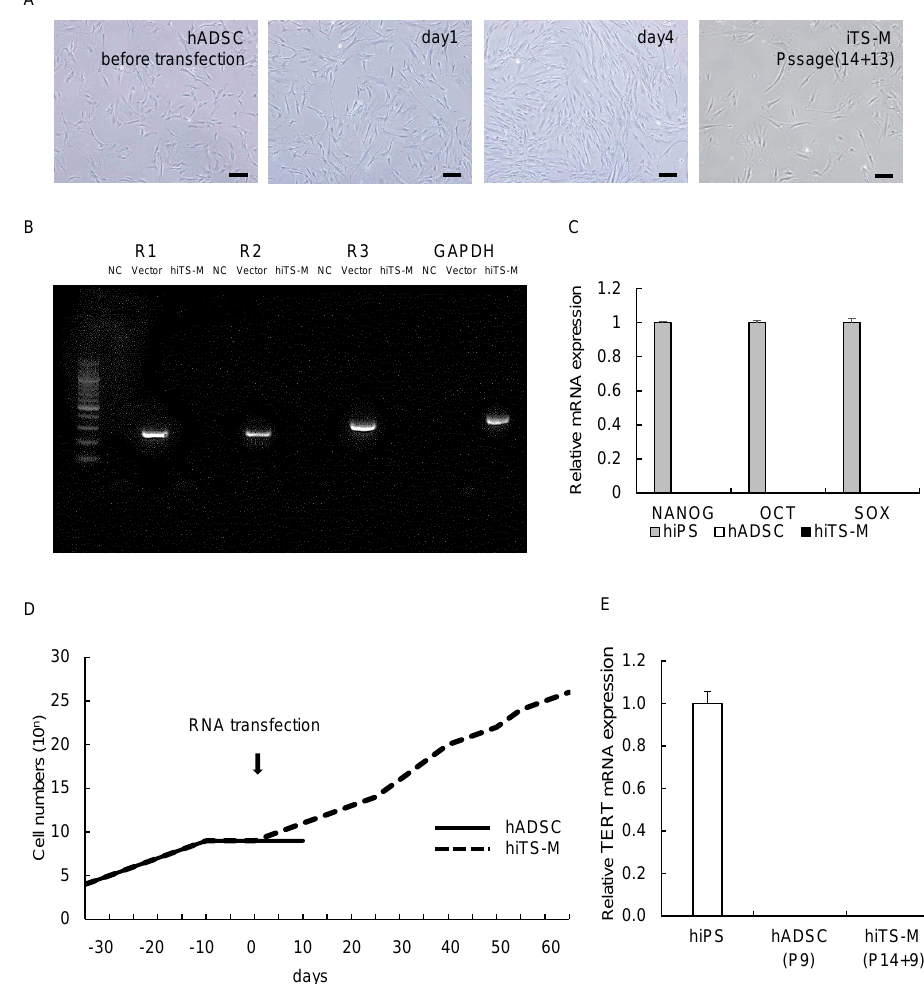
Figure 1. Generation of hiTS-M cells using a synthetic self-replicating RNA. ( A ) Morphology of hADSCs (passage 14) before transfection, one and four days after transfection, and hiTS-M (passage 14 + 13). Scale bars = 100 µ m. ( B ) RT-PCR analysis of persistent VEE-RF RNA Replicon in hiTS-M cells. Total RNA from hiTS-M cells was prepared from passage (14 + 5). Reactions without template served as negative control (NC). VEE-RF RNA Replicon was used as a positive control (Vec). Locations of R1, R2, and R3 are shown in Figure S1A. Amplicon sizes: R1 = 302 bp, R2 = 302 bp, R3 = 394 bp, GAPDH = 452 bp. ( C ) qRT-PCR analysis of NANOG , OCT4 , and SOX2 expression, which are markers of ES/iPS cells, in hiPS cells (passage 20), hADSCs (passage 5), and hiTS-M cells (passage 14 + 5). Data are expressed as NANOG- , OCT4- , and SOX2 -to- GAPDH ratios, with the ratio of iPS cells arbitrarily defined as one ( n = 3). Error bars represent the standard error. ( D ) Growth curves of hADSCs (passage 9 to 14) and hiTS-M cells (passage 14 +and 0 to 15). ( E ) qRT-PCR analysis of hTERT expression in hiPS cells (passage 20), hADSCs (passage 9), and hiTS-M cells (passage 14 + 9). Data are expressed as hTERT -to- GAPDH ratios, with ratio of iPS cells arbitrarily defined as one ( n =